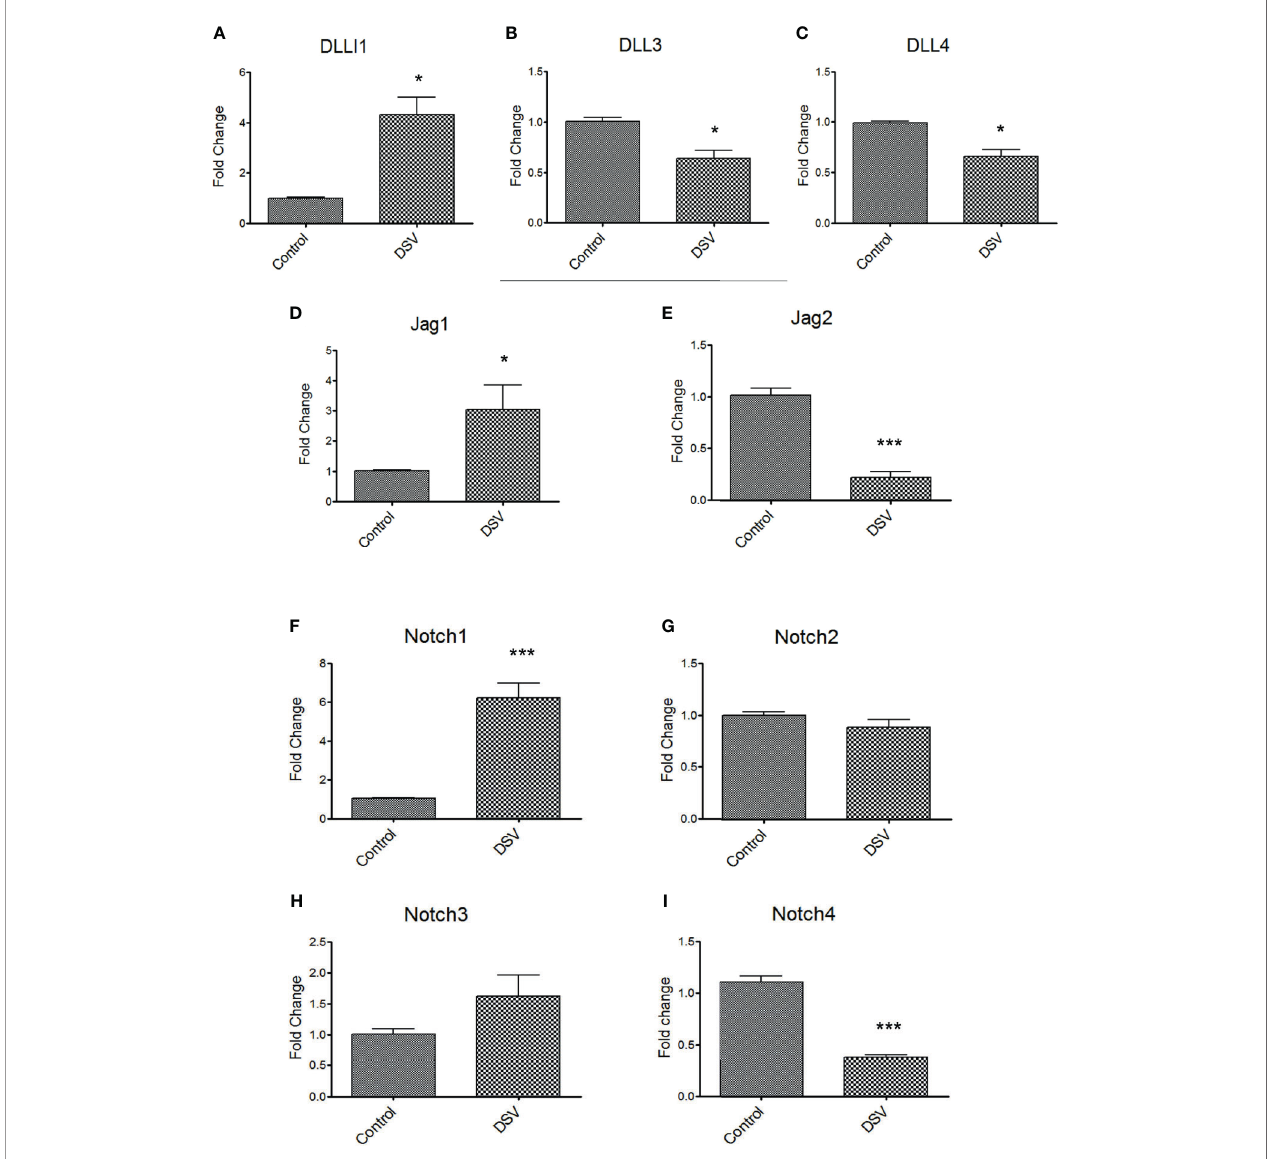
FIGURE 2 | DSV differentially induces gene expression of Notch ligands and receptors RAW cells were treated with DSV ( MOI 20) for 7hrs and harvested, RNA was isolated and cDNA synthesized. QPCR was carried out to determine the gene expression of (A) DLL1, (B) DLL3, (C) DLL4, (D) Jag1, (E) Jag2, (F) Notch1, (G) , Notch2, (H) Notch3, and (I) Notch4 using Taqman probes for respective genes. Relative fold change expression in DSV treated cells compared to untreated control cells was calculated using 2 -ddct method using 18s gene expression as the housekeeping control. A two-tailed t-test was used to determine the statistical difference between control and DSV-treated cells. *p < 0.05, ***p <